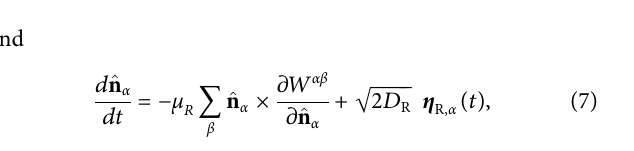
Frontiers in Physics |